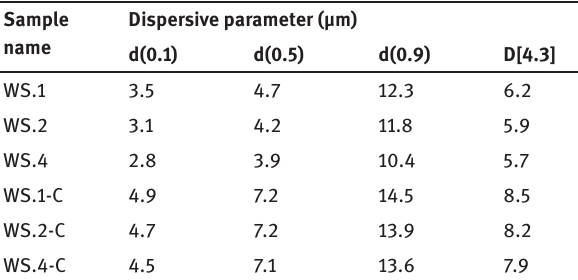
Table 2: Dispersive characteristics of synthesized MgO-ZrO materials.